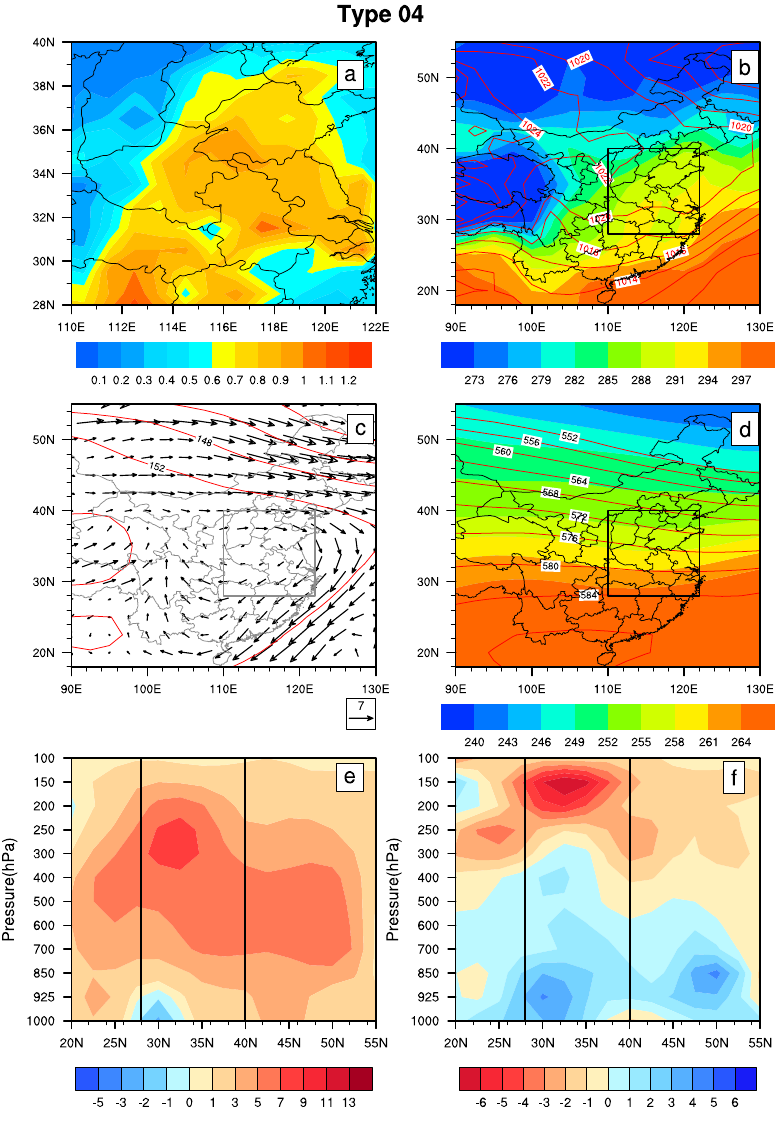
Figure 11. As in Fig. 8 but for Type 4